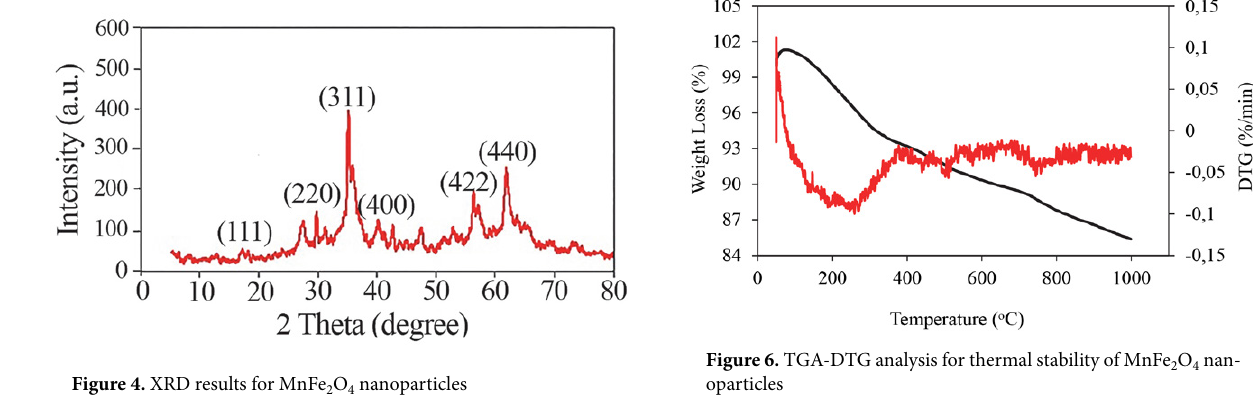
Figure 4. XRD results for MnFe 2 O 4 nanoparticles